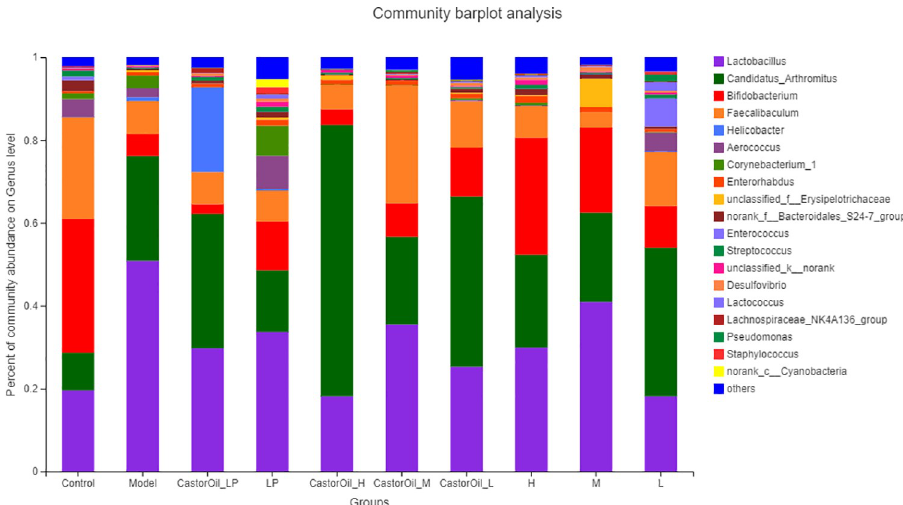
Fig 7. Bar plot analysis of genus level communities in genus level. LP (loperamide), H (high dose of FengLiao), M (medium dose of FengLiao), L (low dose of FengLiao). 1 g/ml FengLiao (H), 0.5 g/ml FengLiao (M), 0.25g/ml FengLiao (L) and 5mg/kg loperamide were pretreated in CastorOil_H, H, CastorOil_M, M, CastorOil_L, L, CastorOil_LP, LP groups once a day for three days respectively. 30 min after the last drug administration, 0.5ml castor oil was used to induce diarrhea in CastorOil_H, CastorOil_M, CastorOil_L and CastorOil_LP groups for 4 h and the intestinal contents were sequenced for bacterial 16S rRNA. Bar graph shows percent of community abundance on genus level. X axis represent groups’ name, Column represents the mean of five